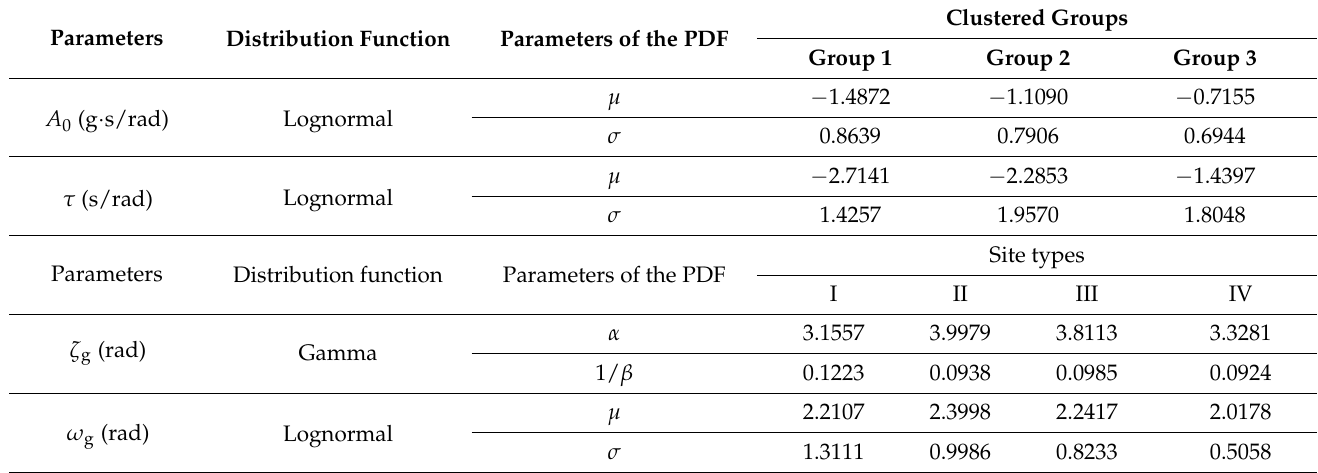
Table 2. Probability distribution of random